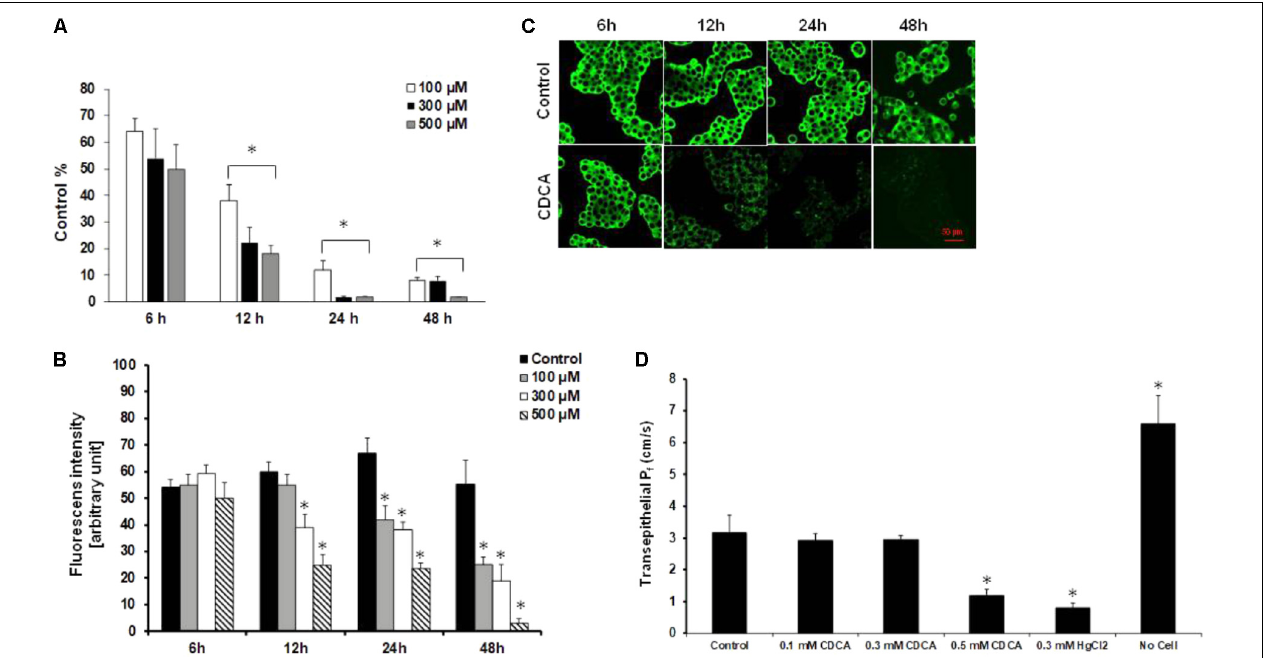
FIGURE 4 | Effect of chenodeoxycholic acid on the expression and activity of AQP1. (A) Capan-1 cells were treated with chenodeoxycholic acid (CDCA) for 6, 12, 24, and 48 h and the relative gene expression of AQP1 was investigated by real-time PCR. Data represent mean ± SEM of three, independent experiments. (B) Protein expression of AQP1 was investigated by immunocytochemistry in Capan-1 cells. Protein expression was measured from the mean fluorescence intensity, normalized to the total cell number and expressed in arbitrary units. Data represent mean ± SEM of three, independent experiments. (C) Representative immunofluorescence staining of Capan-1 cells show the expression of AQP1 after the treatment with CDCA (500 µ M) for 6, 12, 24, and 48 h. (D) Summary bar chart shows the changes in osmotic transcellular water movement (P f ) of Capan-1 cells in the presence of various concentrations of CDCA. Transwell without cells was used for absolute positive control. Data represent mean ± SEM of three, independent experiments. ∗ p ≤ 0.05 vs.